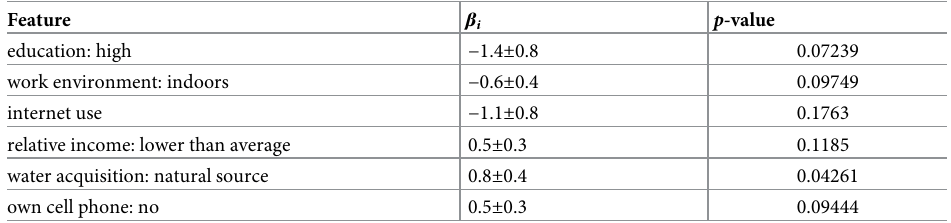
Table 7. Selected SDE features with the best predictive capabilities in the logistic regression